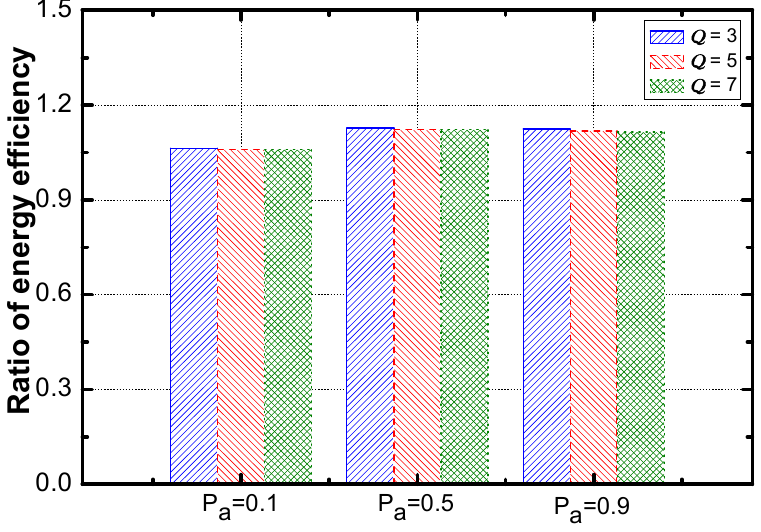
Figure 20. The ratio of energy efficiency vs. P α .